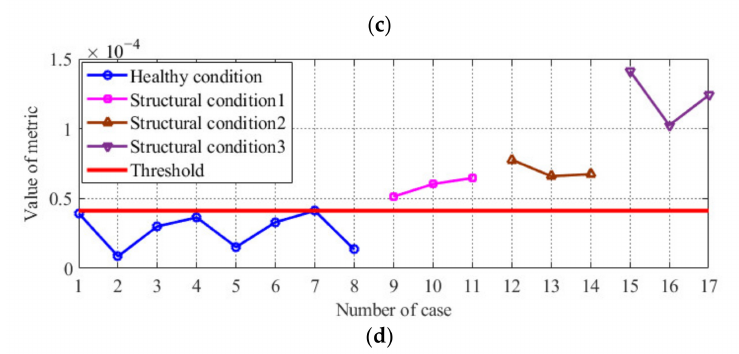
Figure 6. Results of condition diagnosis by using the proposed method: innovation of the #3 sensor for the model bridge under ( a ) structural condition 1; ( b ) structural condition 2; and ( c ) structural condition 3 and ( d ) condition diagnosis results for the model bridge.